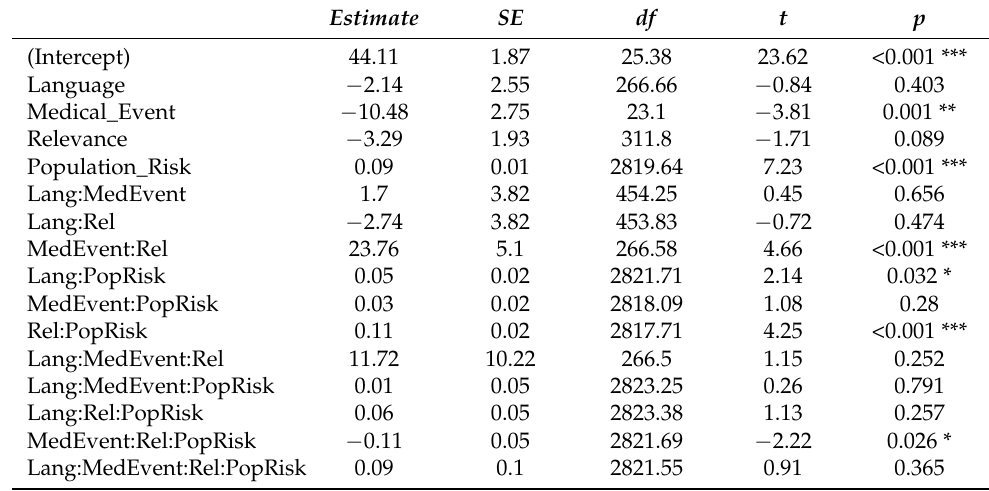
Table A3. Effects of Language, Medical Event, Relevance, and Population Risk on Perceived